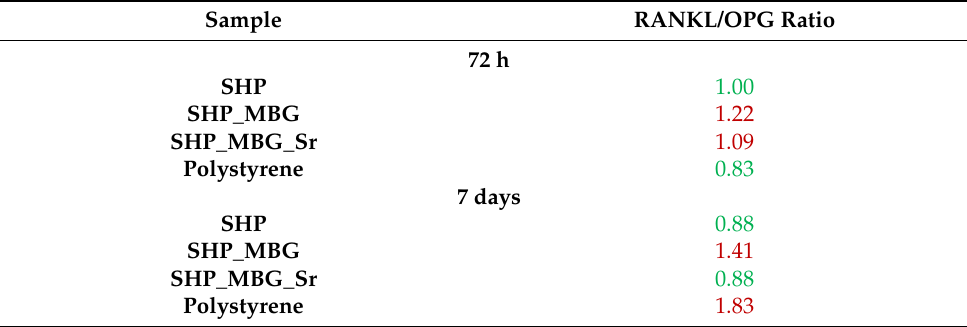
Table 2. RANKL/OPG ratio after 72 h and 7 days of SAOS2 cell culture.